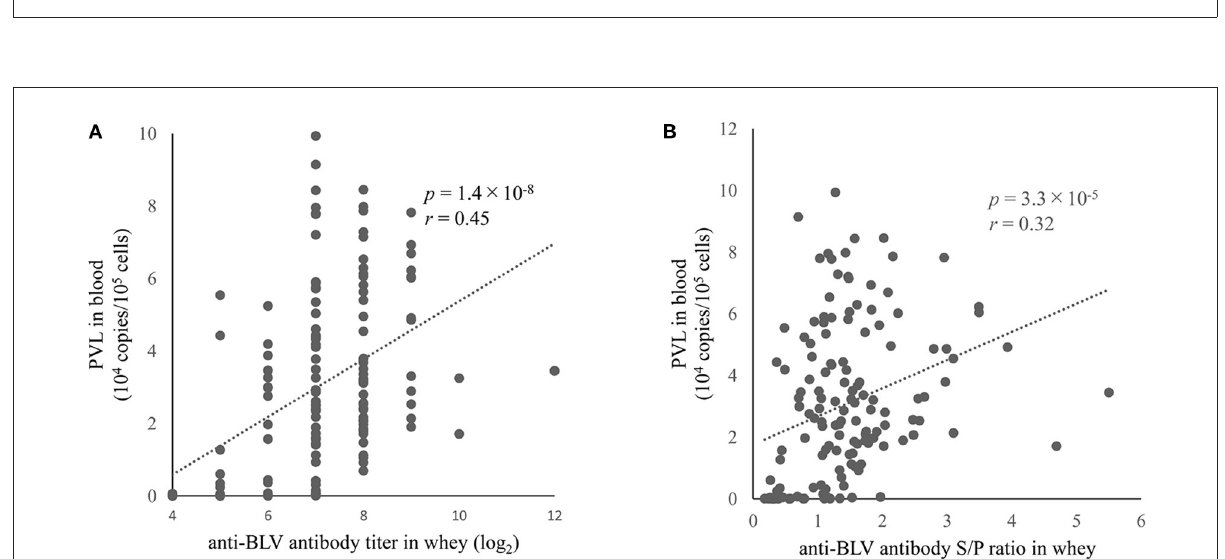
FIGURE3 The correlation between anti-bovine leukemia virus (BLV) antibody in whey and BLV proviral load (PVL) in blood. Anti-BLV antibody titers and S/P ratios for 32-fold dilution in whey were measured using an anti-BLV antibody ELISA. The PVLs in blood were measured using the CoCoMo-qPCR-2 method (RIKEN Genesis, Kanagawa, Japan). (A) The correlation between anti-BLV antibody titer in whey and BLV PVL in blood ( n = 145). (B) Correlation between anti-BLV antibody S/P ratios at 32-fold dilution in whey and BLV PVL in blood ( n = 145).